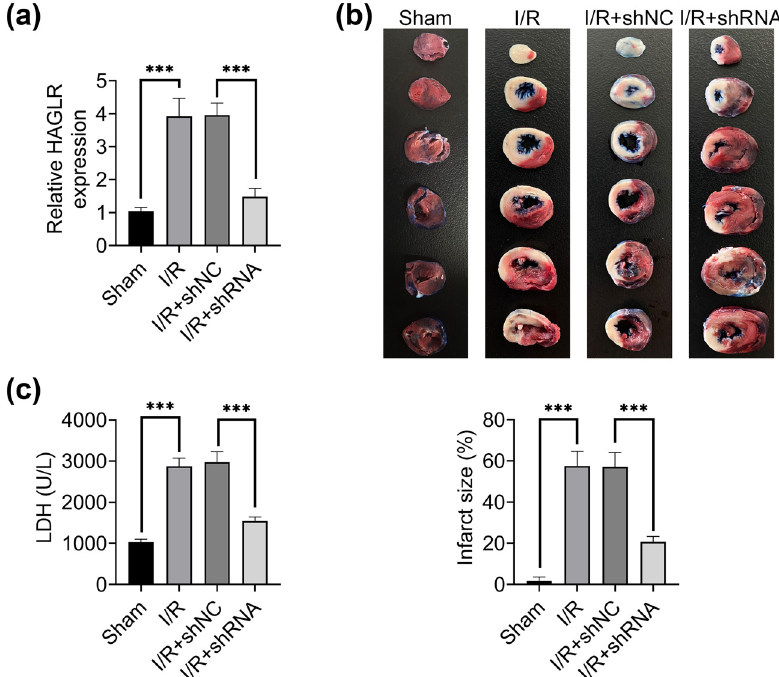
Figure 1: Knockdown of HAGLR alleviated myocardial I/R injury. ( a ) The expression level of HAGLR in I/R mice ( I/R ) and HAGLR - knockdown mice ( I/R + shRNA ) was assessed by qRT - PCR. *** p < 0.001. Data were expressed as mean ± SD of three independent experiments. ( b ) Upper : representative photos of myocardial infarct in I/R and I/R + shRNA groups after TTC staining. Lower : quanti fi cation of myocardial infarct size in I/R and I/R + shRNA groups. *** p < 0.001. Data were expressed as mean ± SD of three independent experiments. ( c ) The LDH level in carotid arterial blood in I/R and I/R + shRNA groups. *** p < 0.001. Data were ex p ressed as mean ± SD of three independent